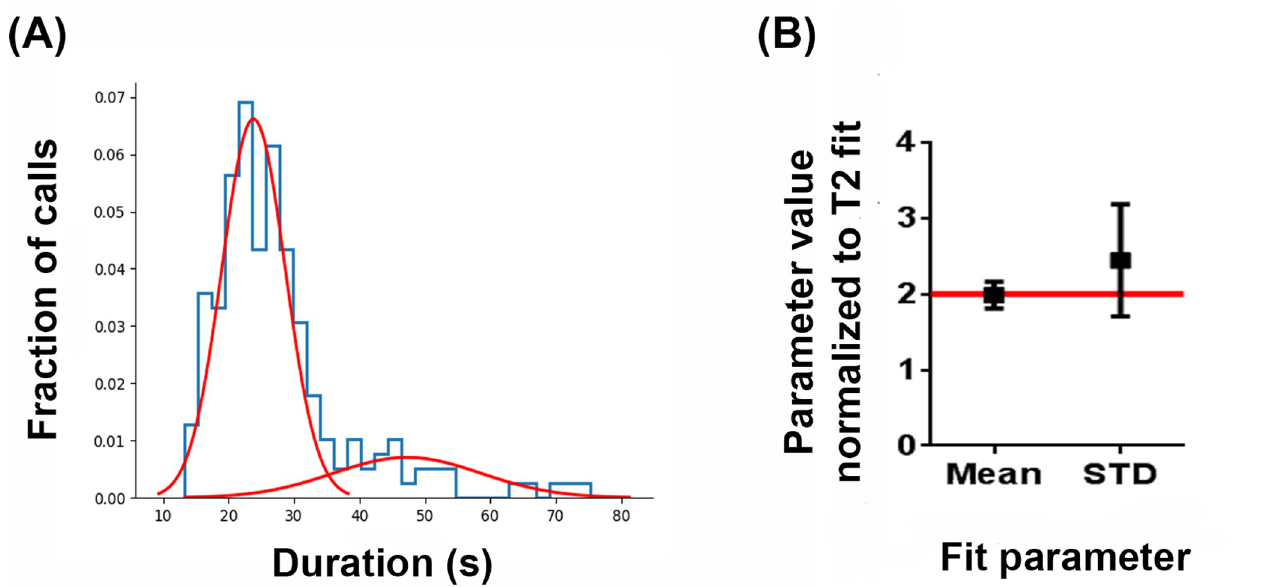
Fig 4. Distribution of T2 and Long T2 intervals. (A) Histogram and individual Gaussian fits for T2 and Long T2 intervals. (B) Scatter plot of the mean and 95% CI of the credible parameter space for the Long T2 intervals’ Gaussian Fit normalized to those of the T2 interval fit. Solid red line indicates the value that would be twice that of the T2